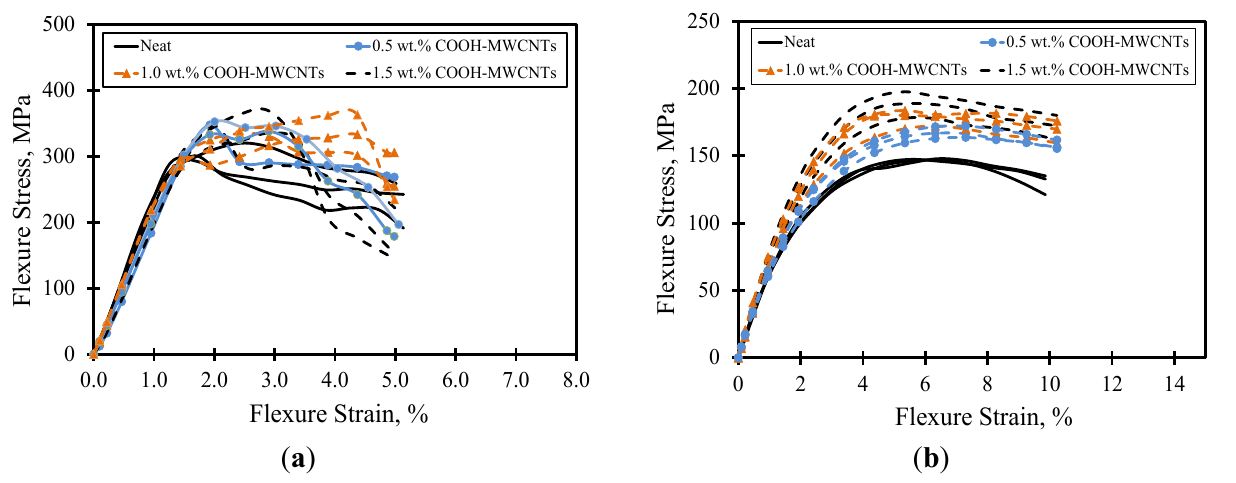
Figure 5. Flexure stress-strain curves for composite plates. ( a ) on-axis; ( b )